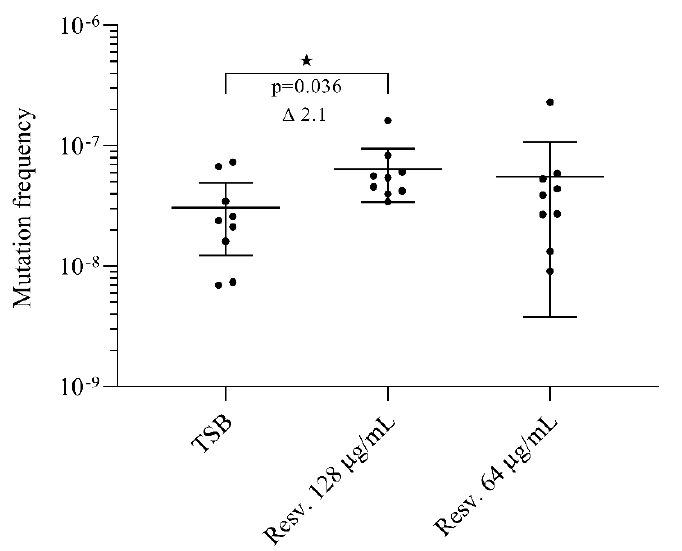
Figure 3. Effect of resveratrol on the recovery of rifampicin resistant mutants. Cells were grown with resveratrol (0.25 × or 0.5 × MIC) or without for 24 h. Rifampicin resistant mutants were selected on agar plates supplemented with rifampicin (5 µ g/mL) and total colony forming units (CFU) were determined on drug-free agar plates. The mutation frequency was calculated as CFU rif /CFU drug free . For each condition, we assessed the mutation frequency for nine biological replicates. The results are shown as individual measurements and with the mean presented. Error bars represent 95% confidence intervals. ★ p < 0.05.